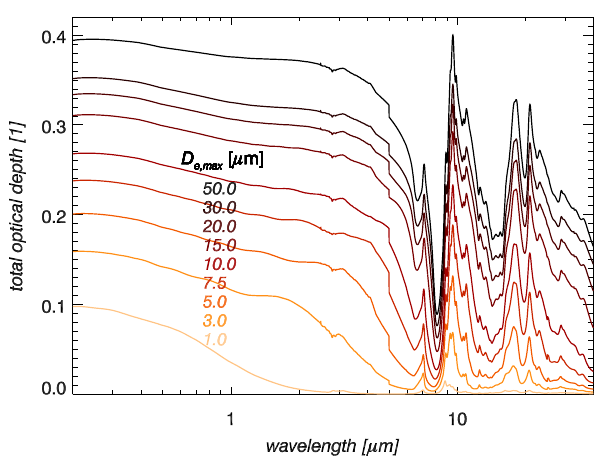
Fig. 7. Simulated spectral total optical depth of spherical mineral dust particles as measured on 19 May 2006 over OZT site about noon. Coloured curves represent various values of the maximum particle diameter D e , max between 1 and 50µm (see Fig.